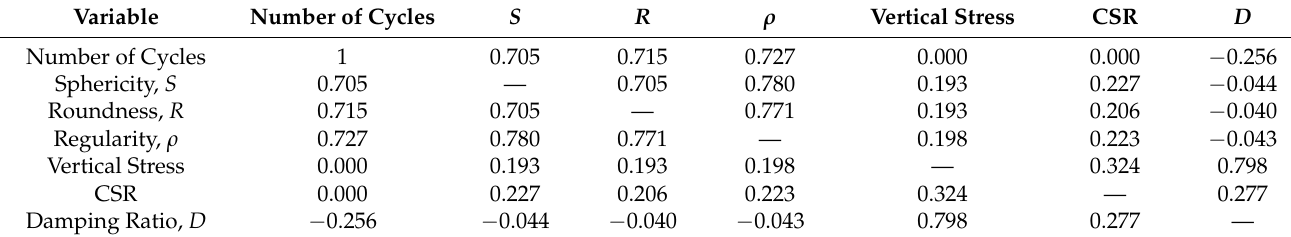
Table 6. Correlation matrix for the input and output variables.